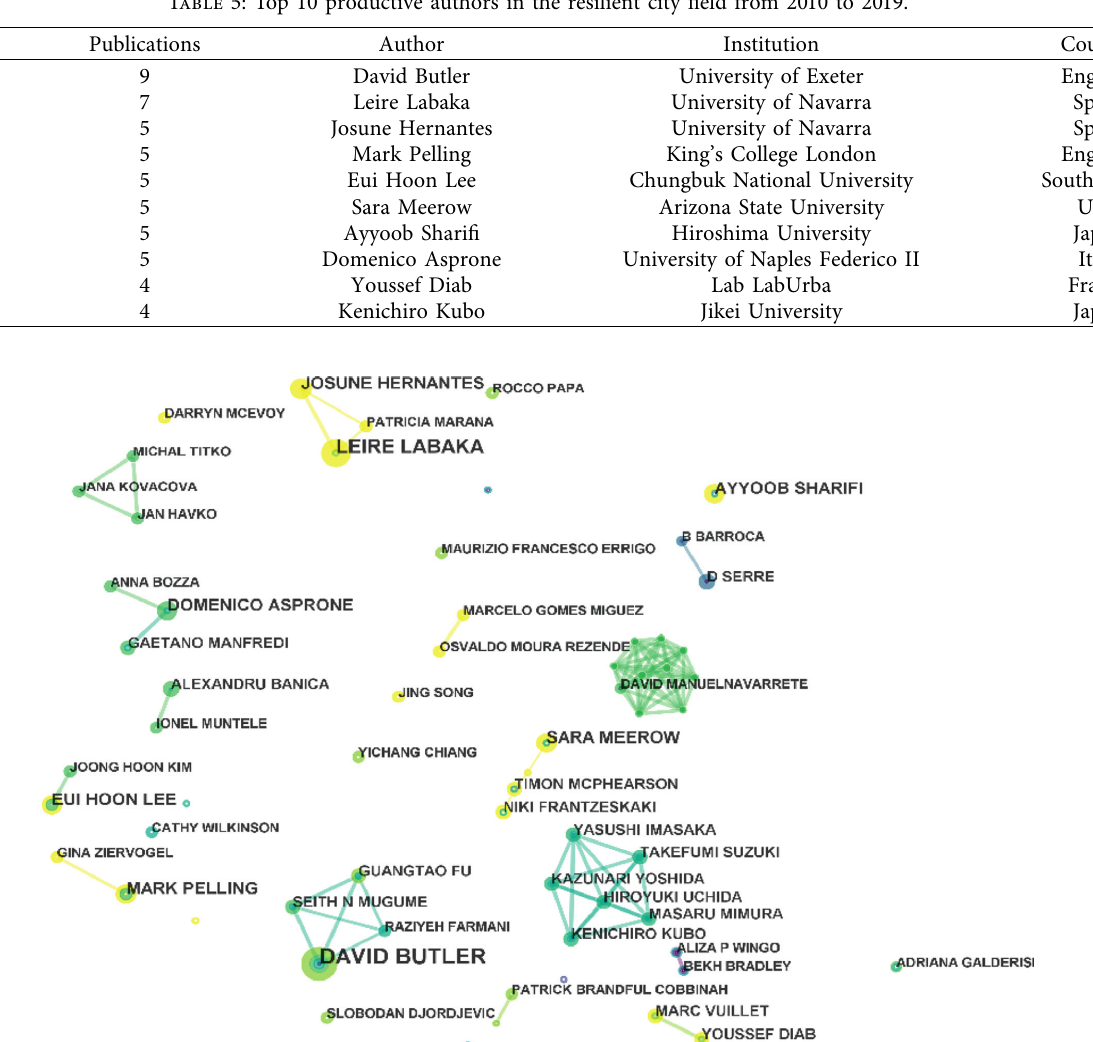
Figure 9: Visualization map of the author cooperation network in the resilient city